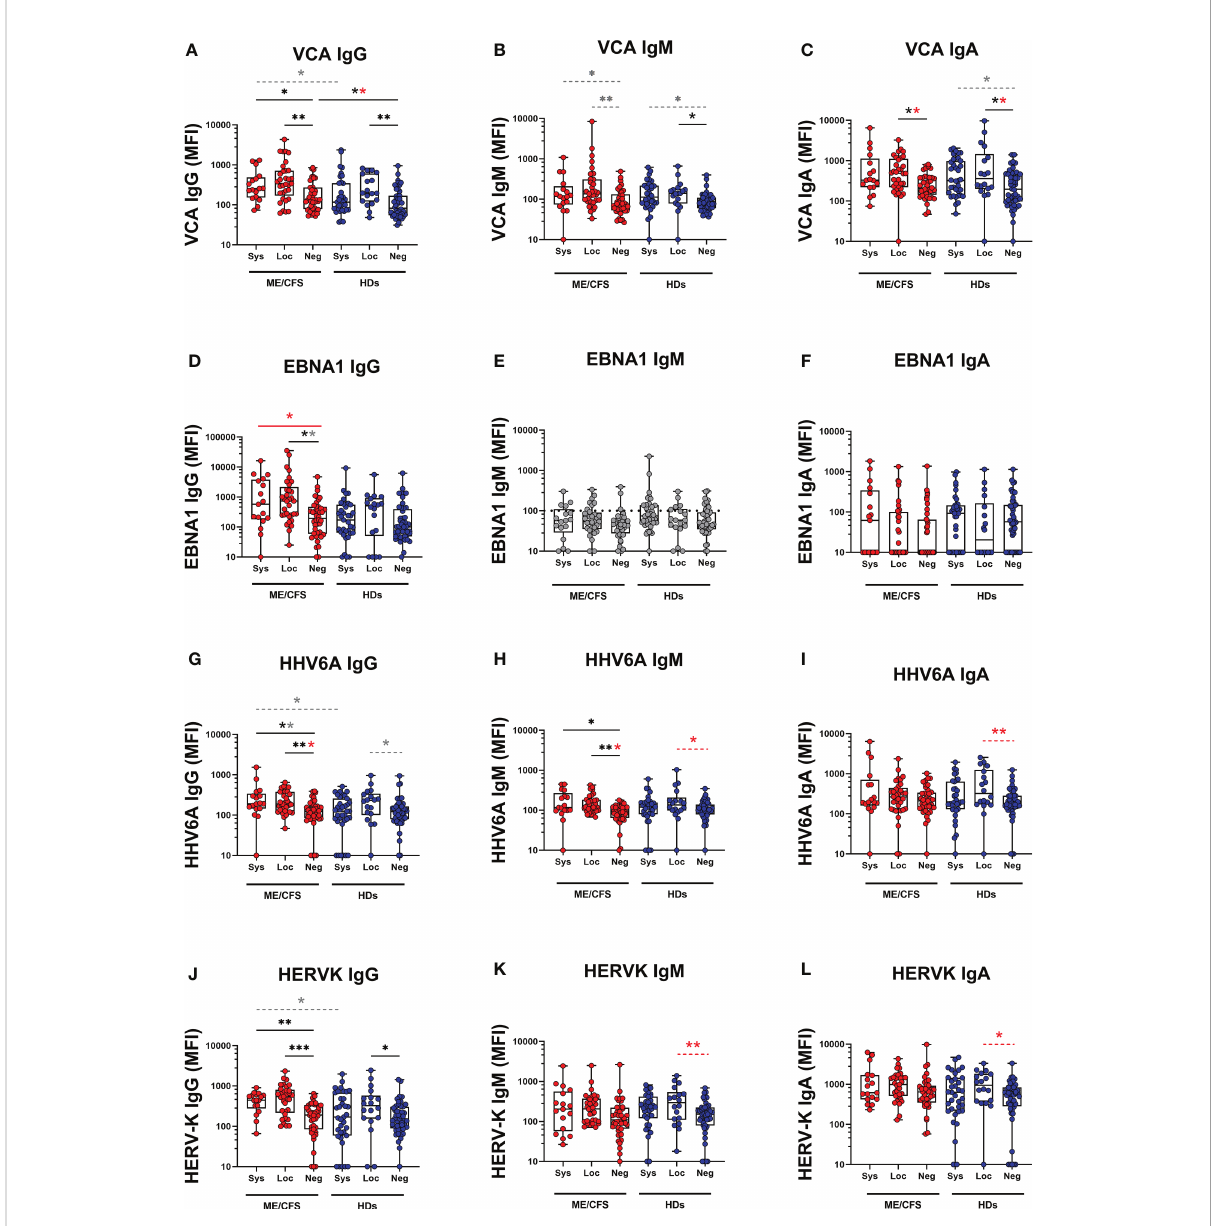
FIGURE 3 Saliva antibody reactivity to herpesviruses and endogenous retrovirus HERV-K in patients with ME/CFS (ME) and healthy donors (HDs). (A) Epstein-Barr virus viral capsid protein (VCA) IgG, (B) VCA IgM, (C) VCA IgA, (D) Epstein-Barr nuclear antigen 1 (EBNA1) IgG, (E) EBNA1 IgM, (F) EBNA1 IgA, (G) human herpes virus 6A (HHV6A) IgG, (H) HHV6A IgM, (I) HHV6A IgA, (J) human endogenous retrovirus K (HERV-K) IgG, (K) HERV-K IgM, (L) HERV-K IgA. Sys, participants RBD-positive for systemic response in plasma. Loc, participants RBD-positive for local response in saliva. Neg, participants RBD-negative both in plasma and saliva. Data are presented as boxplots with median values with 25 th and 75 th percentile. MFI, median fl uorescence index. Statistically signi fi cant differences according to non-parametric Kruskal-Wallis procedure and false discovery rate adjustment (5%), are indicated as * p < 0.05 , ** p < 0.01 , *** p < 0.001 ; ns , non-signi fi cant. Dimmed dots and dashed line indicates absence of antibodies (assay background levels). Dimmed/grey p -value asteriks* indicate loss of signi fi cance after confounding factor (age and gender) analysis with multiple linear regression and adjustment for FDR of 5% according to Benjamini, Krieger, Yekutieli. Red p-values asteriks* indicate gain of signi fi cance after adjustment, and black p-value asteriks* indicate no change after